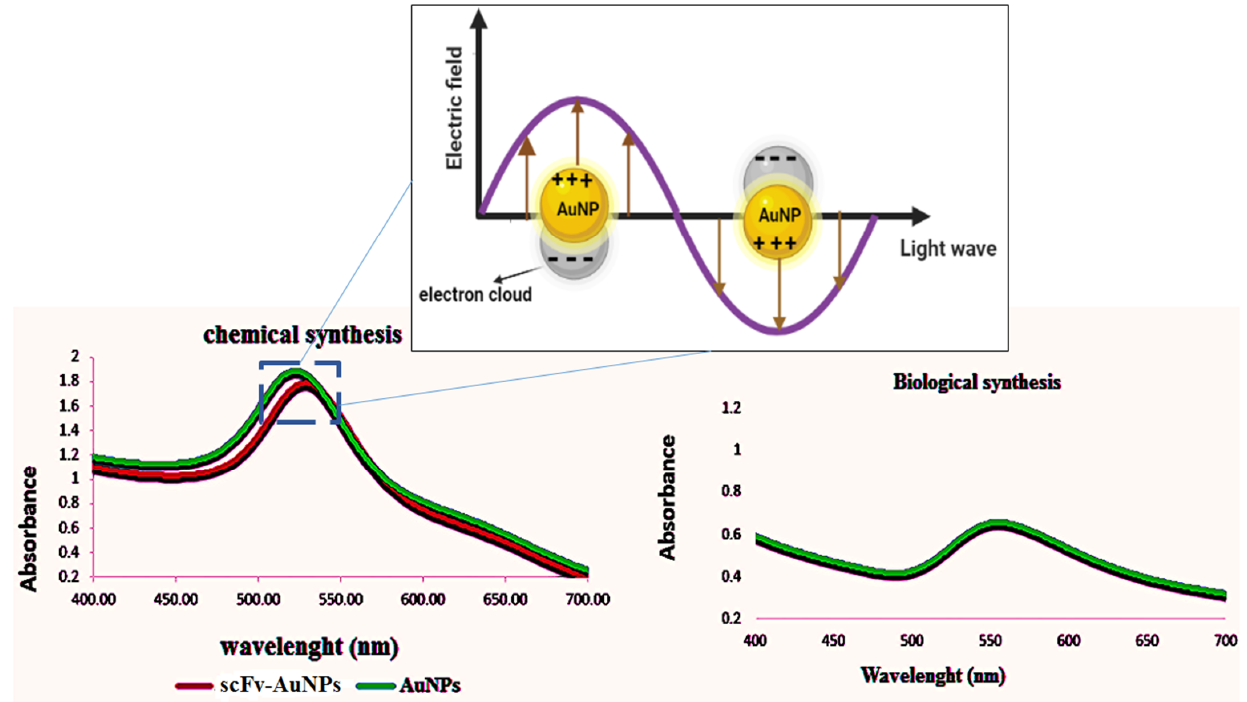
Figure 5. The absorption peak of chemically synthesized AuNPs changed after binding to scFv.